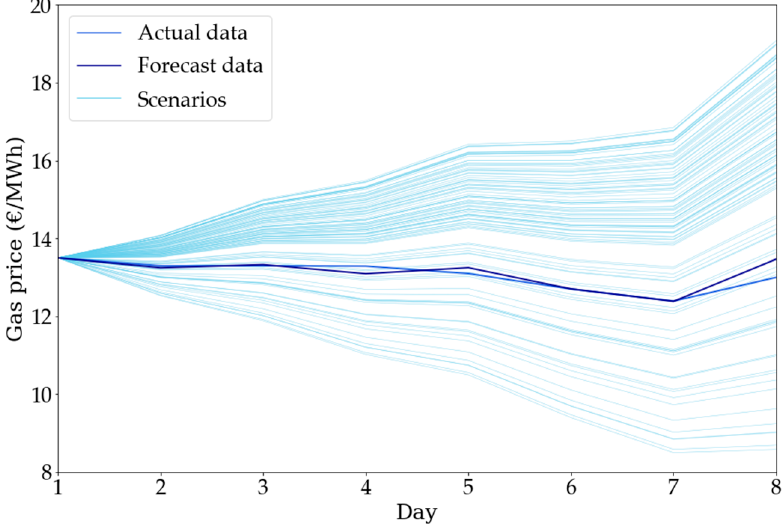
Figure 10. Gas price time series forecast and 100 scenarios.